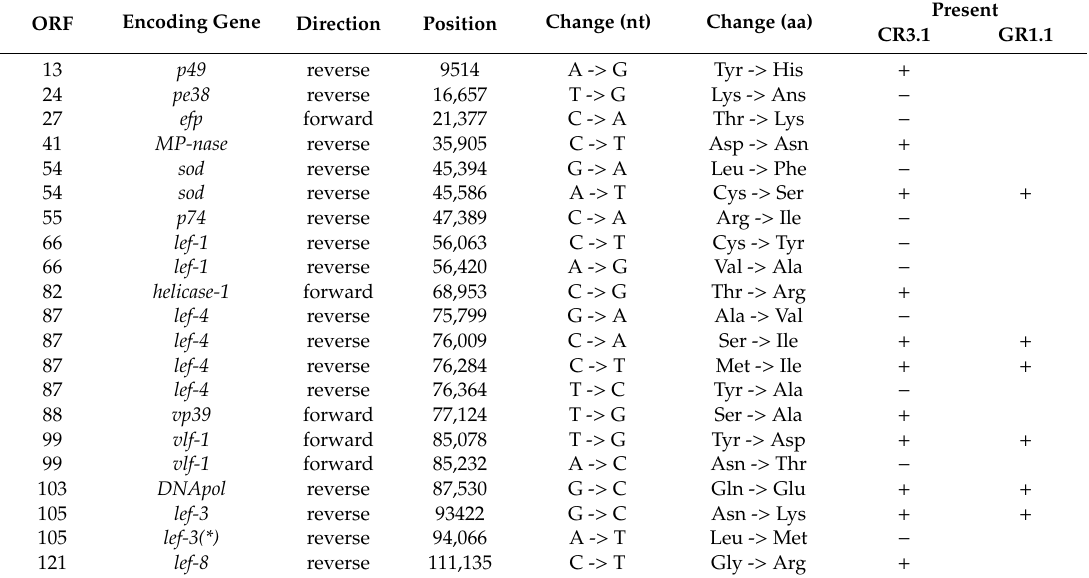
Table 2. Single nucleotide polymorphisms (SNPs) in PhopGV-R open reading frames (ORF) with known functions in relation to the reference isolate PhopGV-1346 (NC004062). SNPs occurred in the majority of reads ( > 51%) with one exception (*) where a minority of 22.4% was detected. The occurrence of the respective SNPs in PhopGV-CR3.1 and PhopGV-GR1.1 is indicated with ( + ) for majority and ( − ) for minority number of reads supporting this